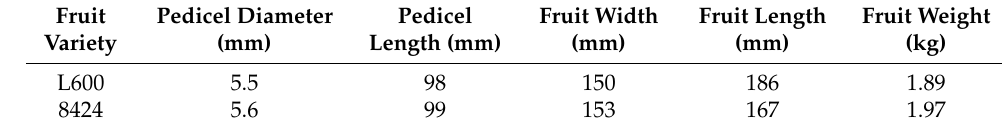
Table 1. Physical parameters of L600 and 8424 watermelons.